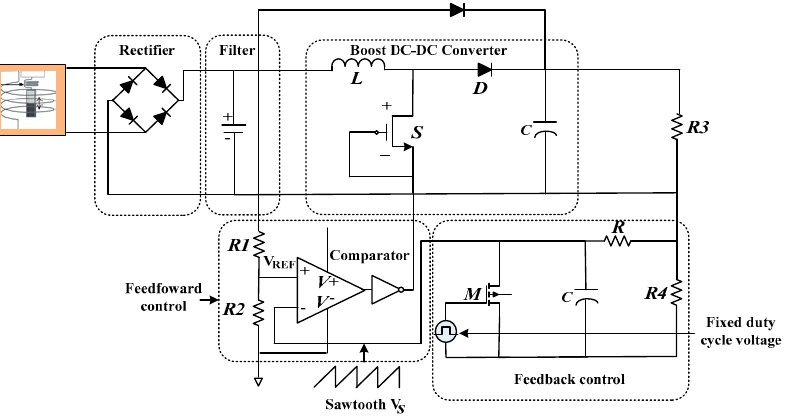
Figure 19. Energy harvesting circuit with boost converter for feedforward and feedback control [115].